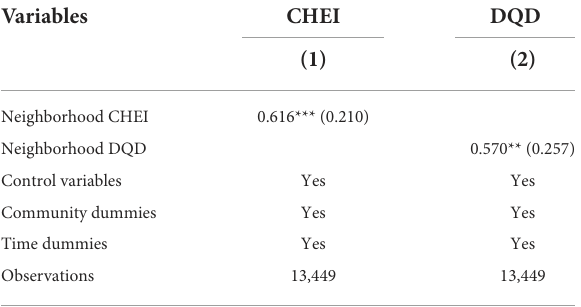
TABLE 6 Estimation of neighborhood effects on dietary behaviors of older adults (2SLS